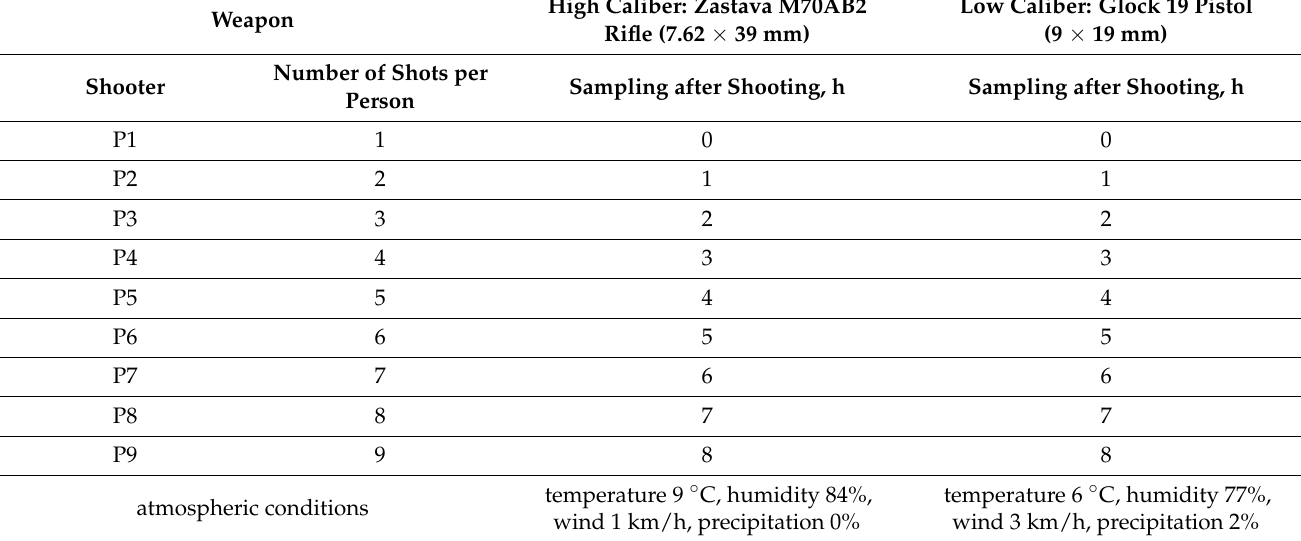
Table 2. Experimental plan for studying the number of GSR particles as a function of the number of shots and the postdischarge